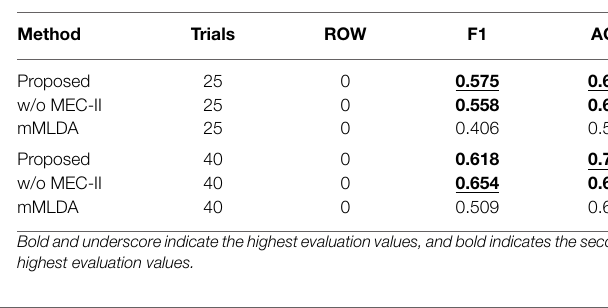
Frontiers in Neurorobotics |